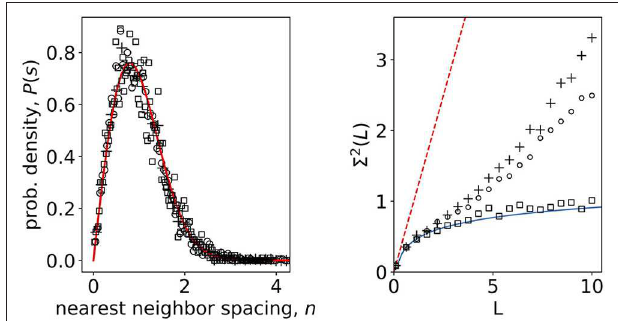
FIGURE 3 | (Left) Nearest-neighbor spacing distribution of empirical correlation matrix eigenvalues of calcium signals in non-stimulatory and stimulatory regime. Open squares: shuffled, randomized data; open dots: 8mM glucose; crosses 6mM glucose; full line Wigner surmise (Equation 5). (Right) Number variance of eigenvalue spectra of calcium signals. Open squares: shuffled, randomized data; open dots: 8mM glucose; crosses 6mM glucose; full line RMT prediction Σ 2 ( L ) (Mehta, 2004); dashed line Poissonian limit Σ 2 ( L )